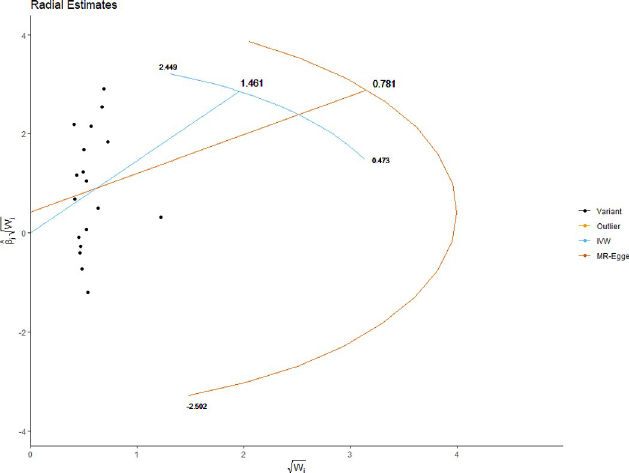
Fig 20. Radial plot of hip circumference as the exposure. No significant outliers were